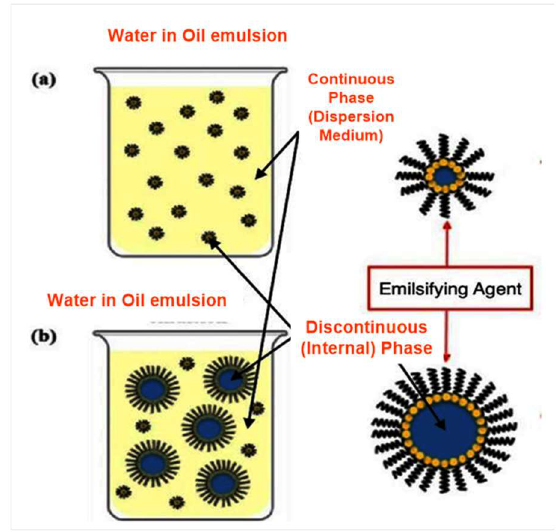
Figure 4. Schematic illustration of nanoemulsions with ( a ) oil-in-water emulsions and ( b ) water-in-oil emulsions, with surfactants being the emulsifying agent.